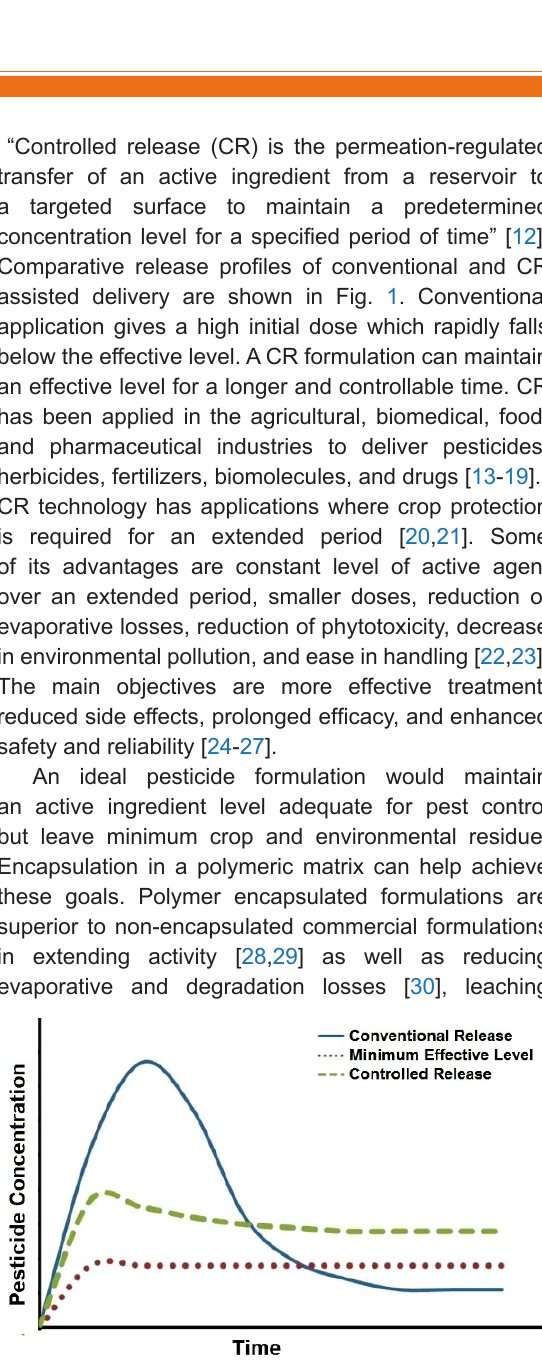
Figure 1. Theoretical pesticide active site concentrations from conventional and controlled release.